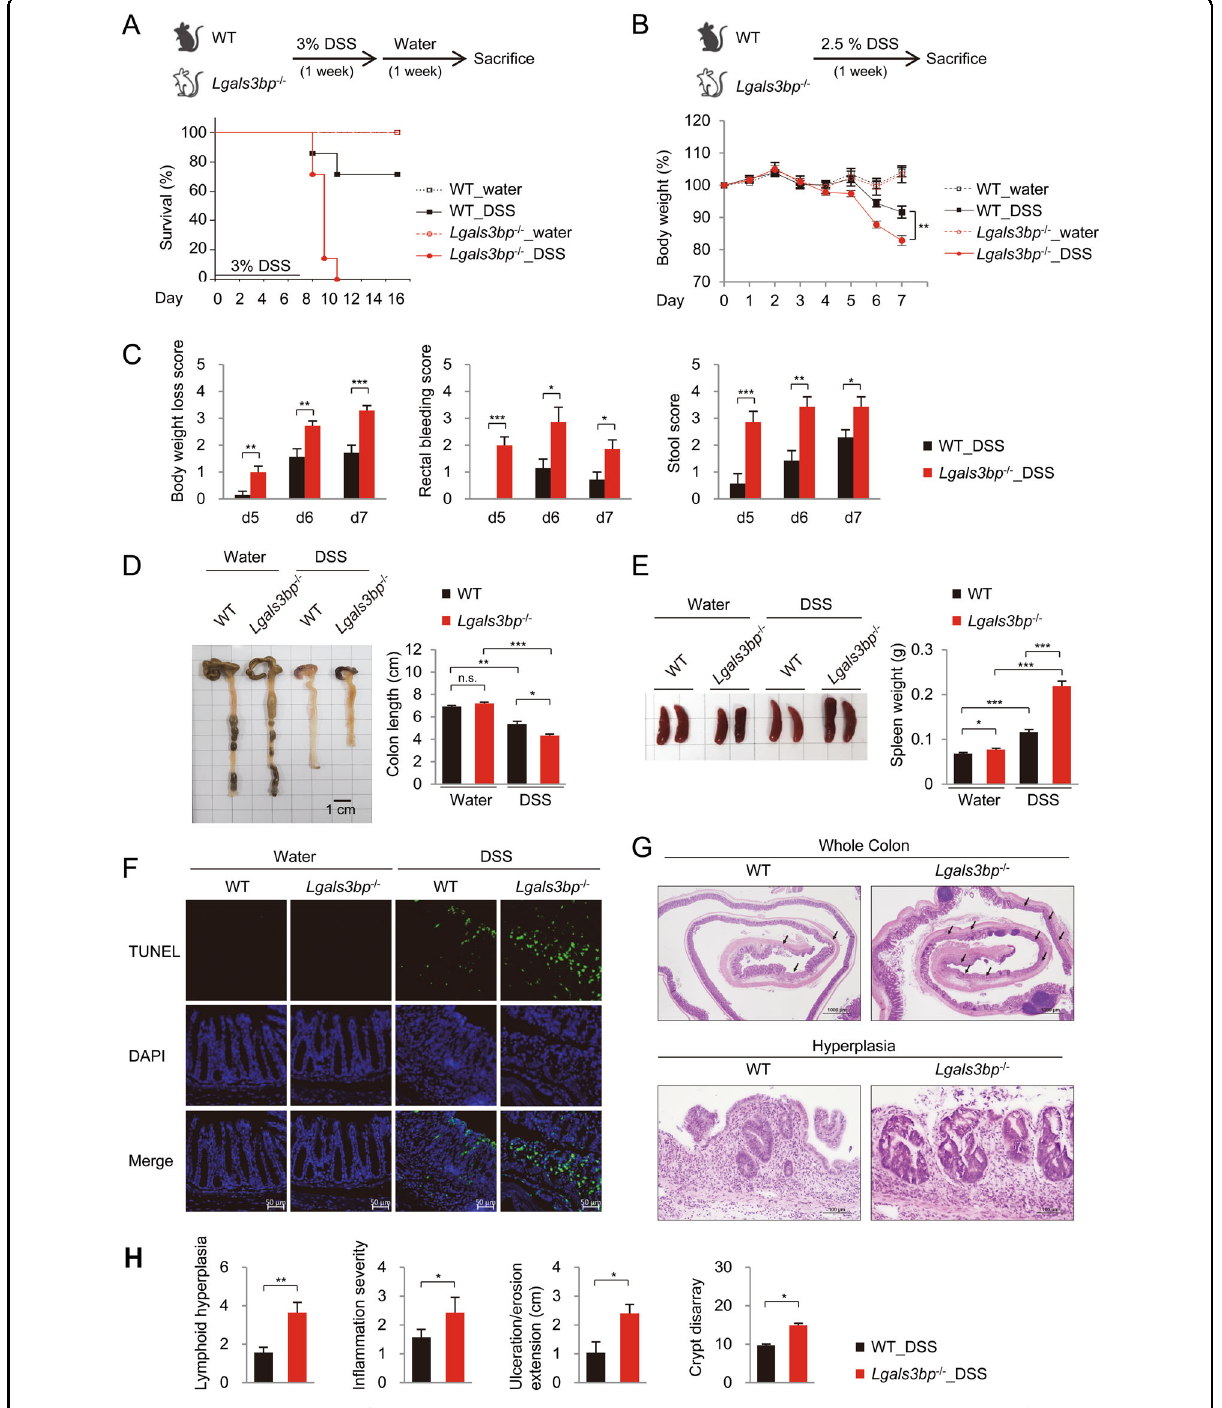
Fig. 2 Hyper-susceptibility of Lgals3bp − / − mice to DSS-induced colitis. A Relative survival rate. WT ( n = 7) or Lgals3bp − / − ( n = 7) mice were orally administrated 3% DSS in drinking water for 7 days, followed by regular drinking water. Survival was monitored until day 15 after the start of DSS administration. WT ( n = 4) or Lgals3bp − / − ( n = 4) mice provided with water served as controls. B – E WT ( n = 7) and Lgals3bp − / − ( n = 7) mice were fed 2.5% DSS for 7 days. B Body weight change and ( C ) disease activity index of mice while administering 2.5% DSS in drinking water. D Colon length and ( E ) spleen weight measurement at day 7 after 2.5% DSS administration. (F-H) WT and Lgals3bp − / − mice were fed 2.5% DSS for 7 days, followed by regular drinking water for 7 days. F Fluorescent microscopy images of TUNEL stained apoptotic cells in paraf fi n sections of mouse colons counterstained with DAPI. G Upper: Representative pictures of H&E-stained colon tissue sections. Arrow indicates histopathological changes. Lower: Representative dysplasia in the colon. H Histological analysis of colon tissue. H&E stained sections were scored as described in Materials and Methods. Data are presented as means ± SEM. * p < 0.05; ** p < 0.01; *** p < 0.001; **** p <